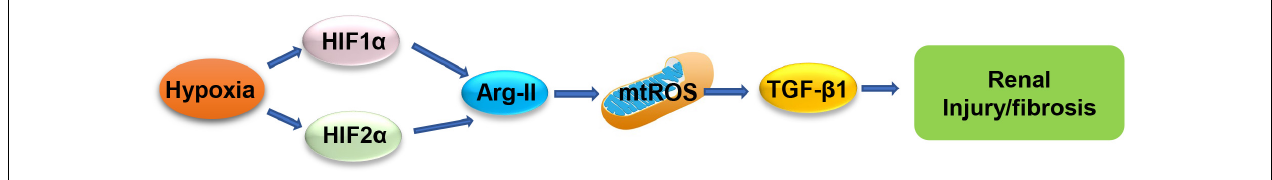
FIGURE 8 | Schematic illustration of mechanisms of hypoxia-induced renal epithelial injury and fibrotic pathway through HIFs-Arg-II-mtROS-TGF β 1